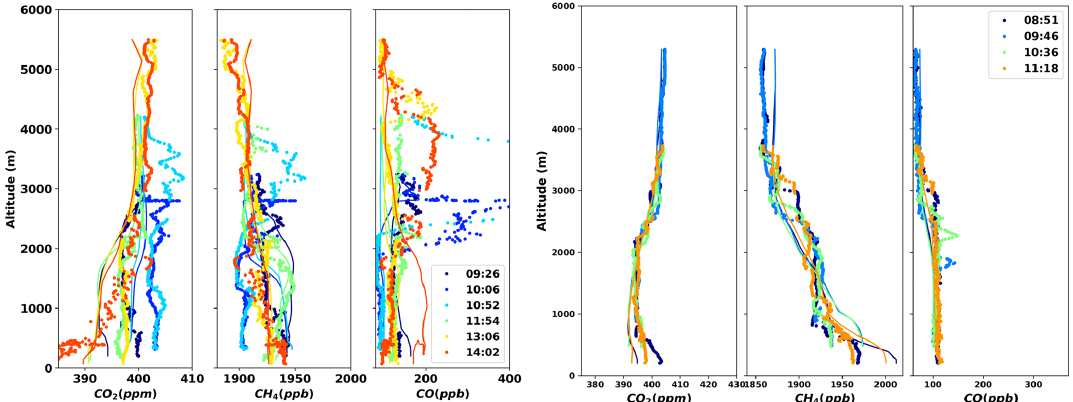
Figure 10. Observation (dotted lines) and model estimates (thin lines) of profiles on 10 July 2017 (left) and 30 August 2017 (right) from a transect up the Mackenzie River in the Northwest Territory of Canada. Dotted lines show observations, and thin lines show model estimates corresponding to specific times during the transect.